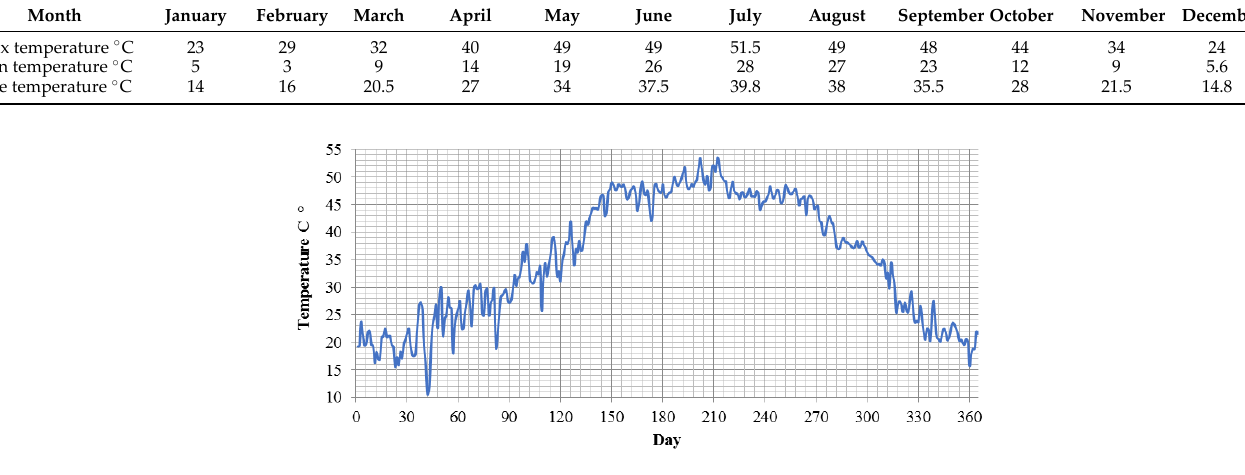
Figure 11. Monthly temperature in Ahvaz [80].